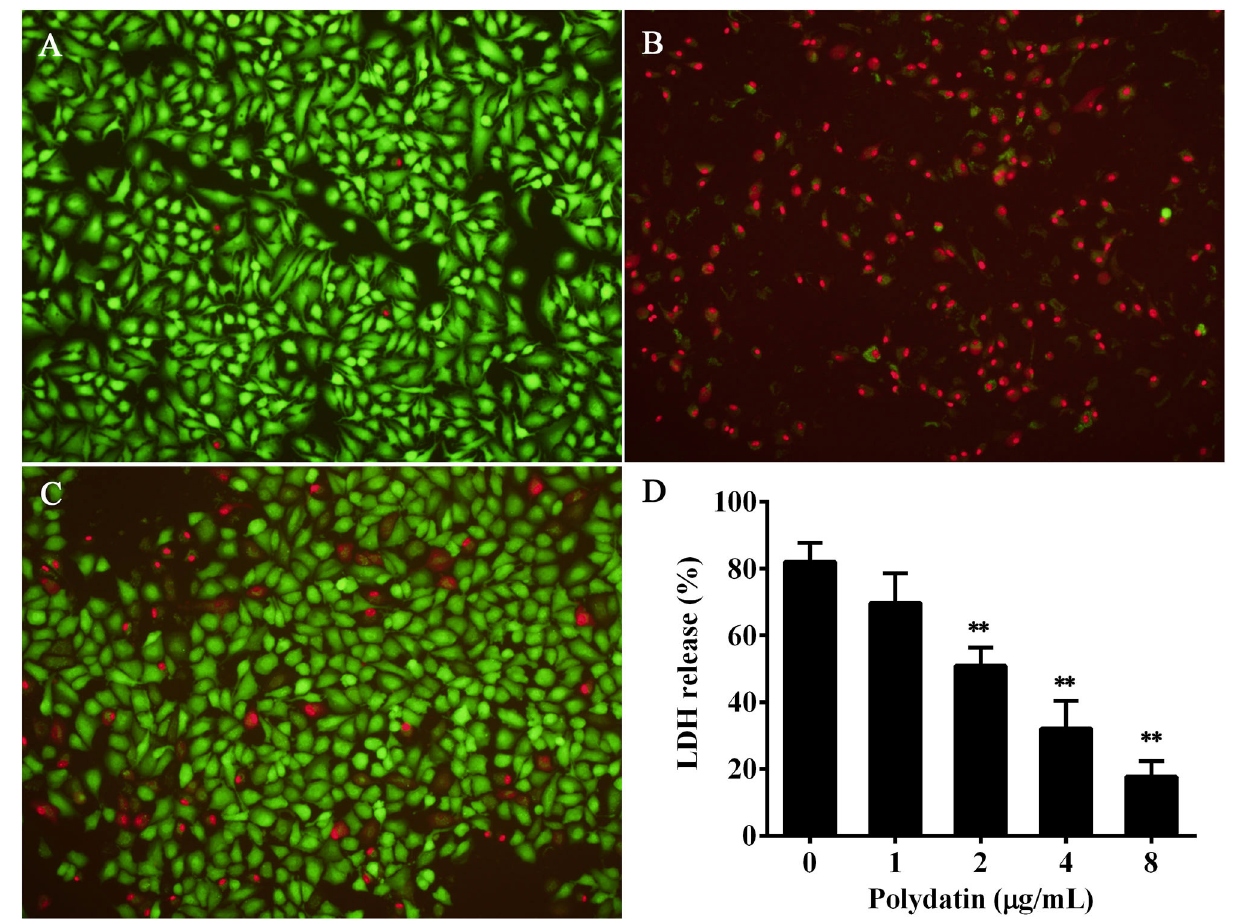
FIGURE 3 | Polydatin protected A549 cells against aerolysin mediated cell injury. (A–C) were cell viability determined by live/dead staining, (A) live cells without any treatment, (B) cells co-cultured with bacterial supernatant without polydatin treatment, (C) cells co-cultured with bacterial supernatant treated with 8 µ g/ml polydatin. (D) Cell injury determined by lactate dehydrogenase (LDH) release assay. Data in (D) are the mean ± SD of three independent assays, ** indicates p < 0.01.